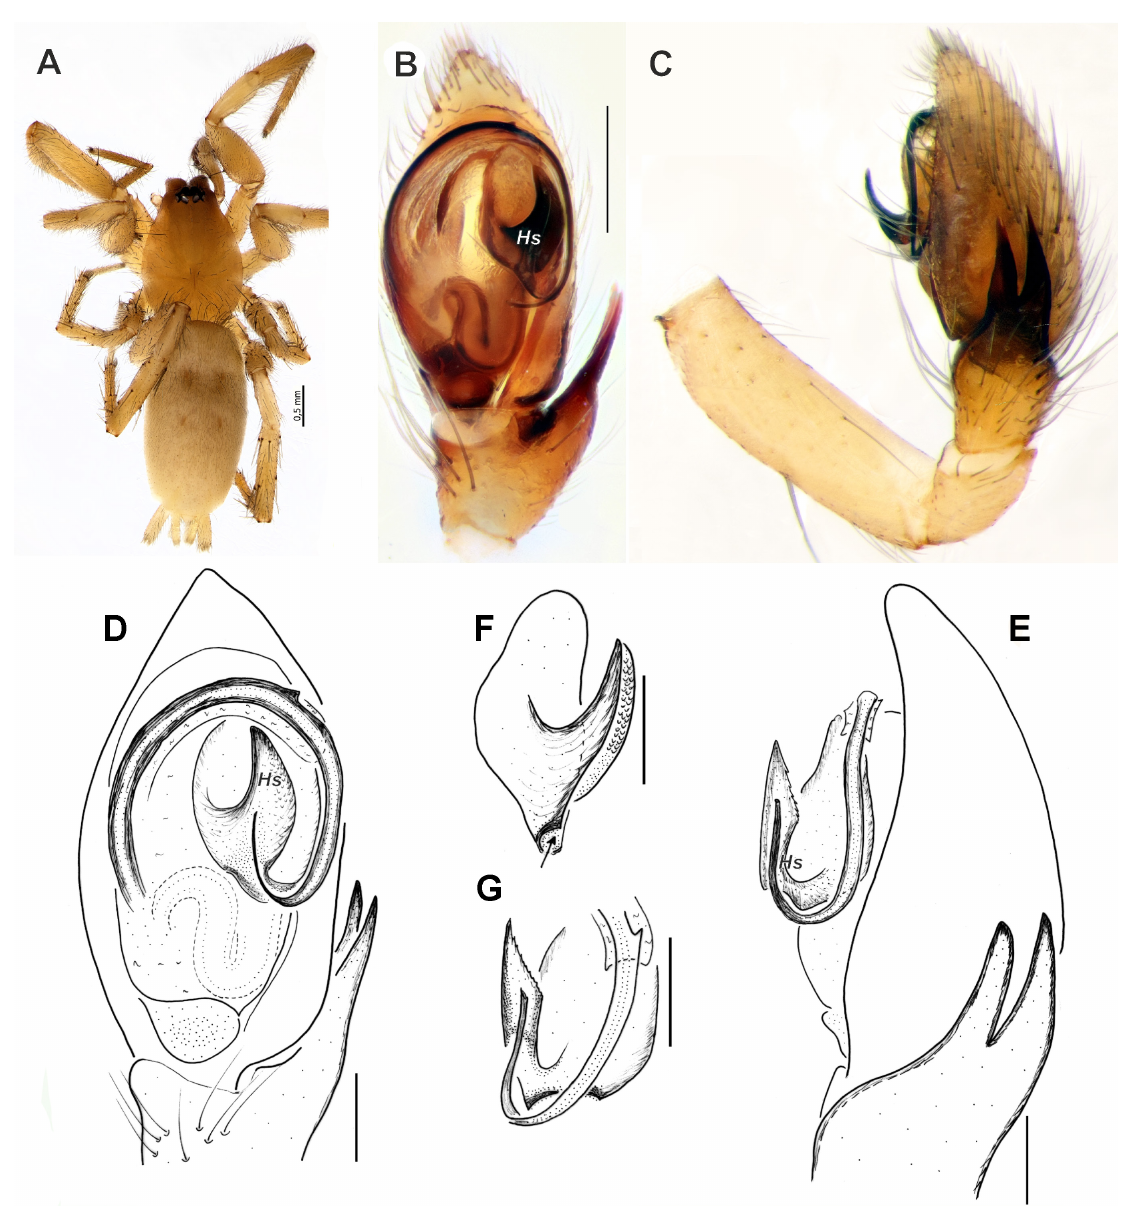
Fig. 1. Berinda bifurcata sp. nov., holotype, ♂ (MHNG). A . Habitus, dorsal view. B, D . Palp, ventral view. C, E . Palp, retrolateral view. F–G . Hook-like structure, proventral and retrolateral views; arrow points to the entrance for the embolus. Abbreviation: Hs = hook-like structure. Scale bars: A = 0.5 mm; B = 0.2 mm; D–G = 0.1